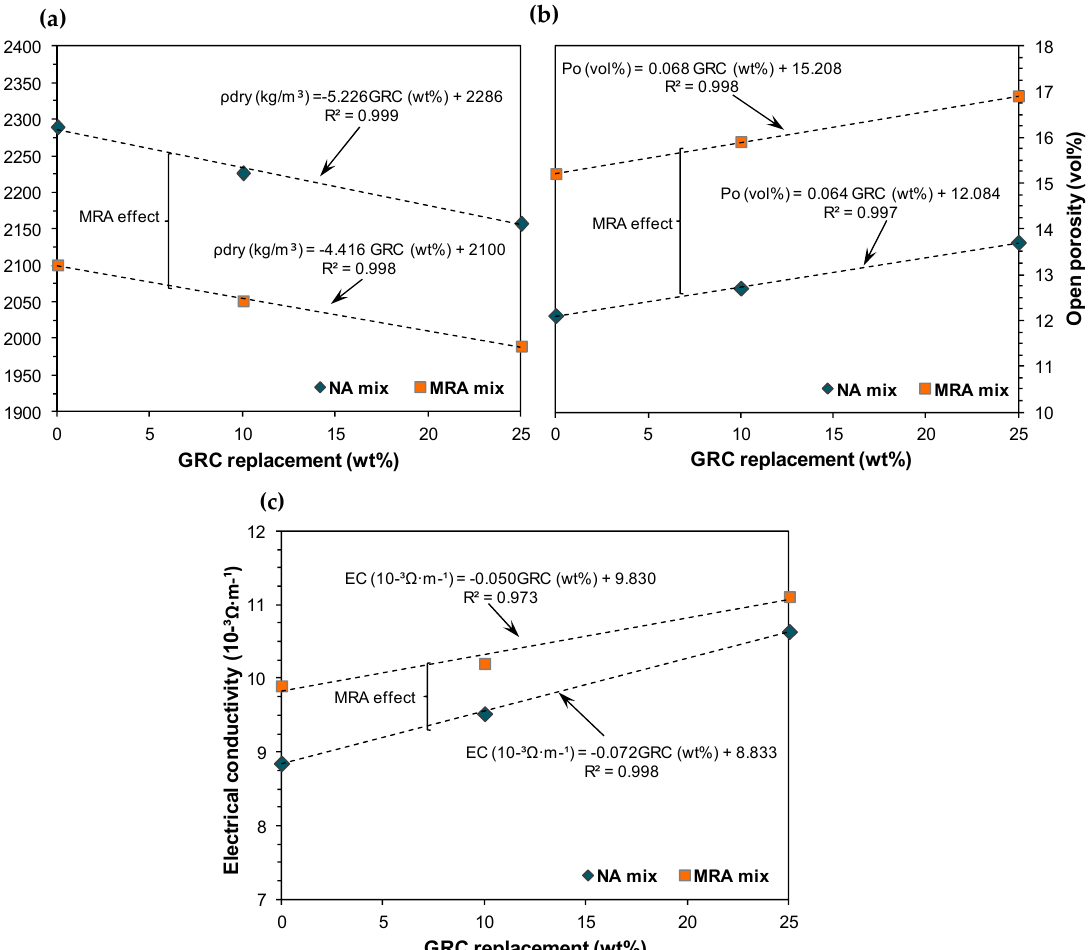
Figure 4. ( a ) Open porosity; ( b ) dry density; and ( c ) electrical conductivity as a function of the GRC replacement ratio.